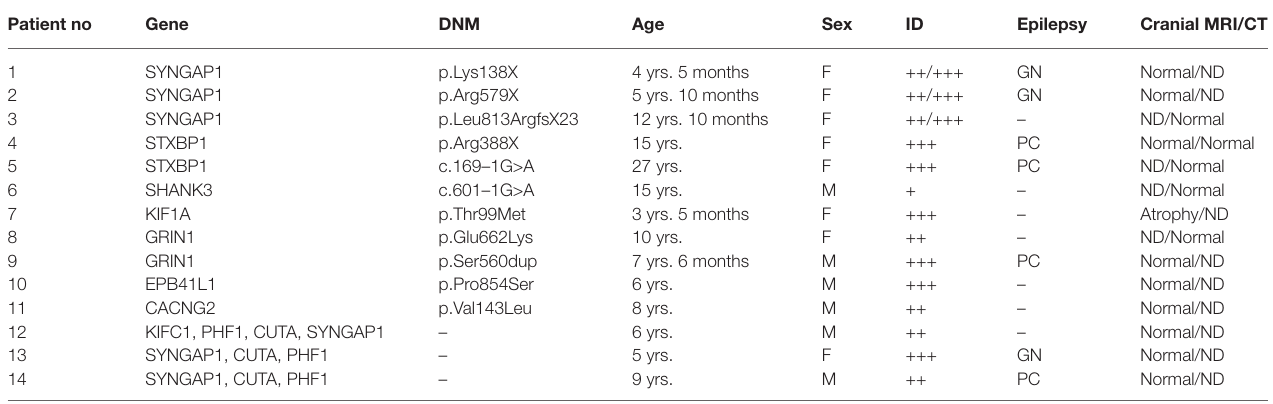
TABLE 2 | Clinical features observed in patients with SYNGAP1 heterozygous mutation . Patient no Gene DNM Age Sex ID Epilepsy Cranial